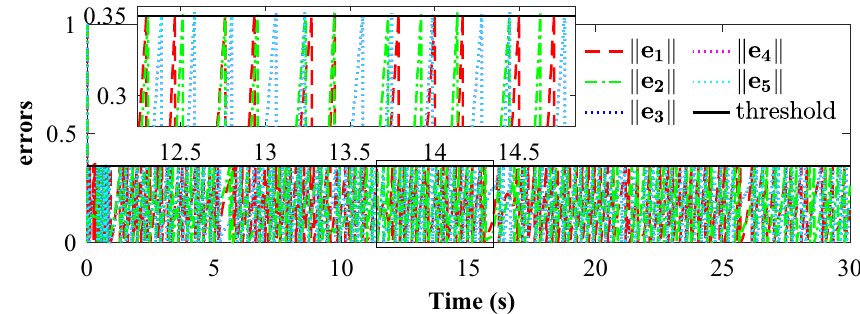
Figure 6. Simulation results: The event-triggered measurement error for different agents.